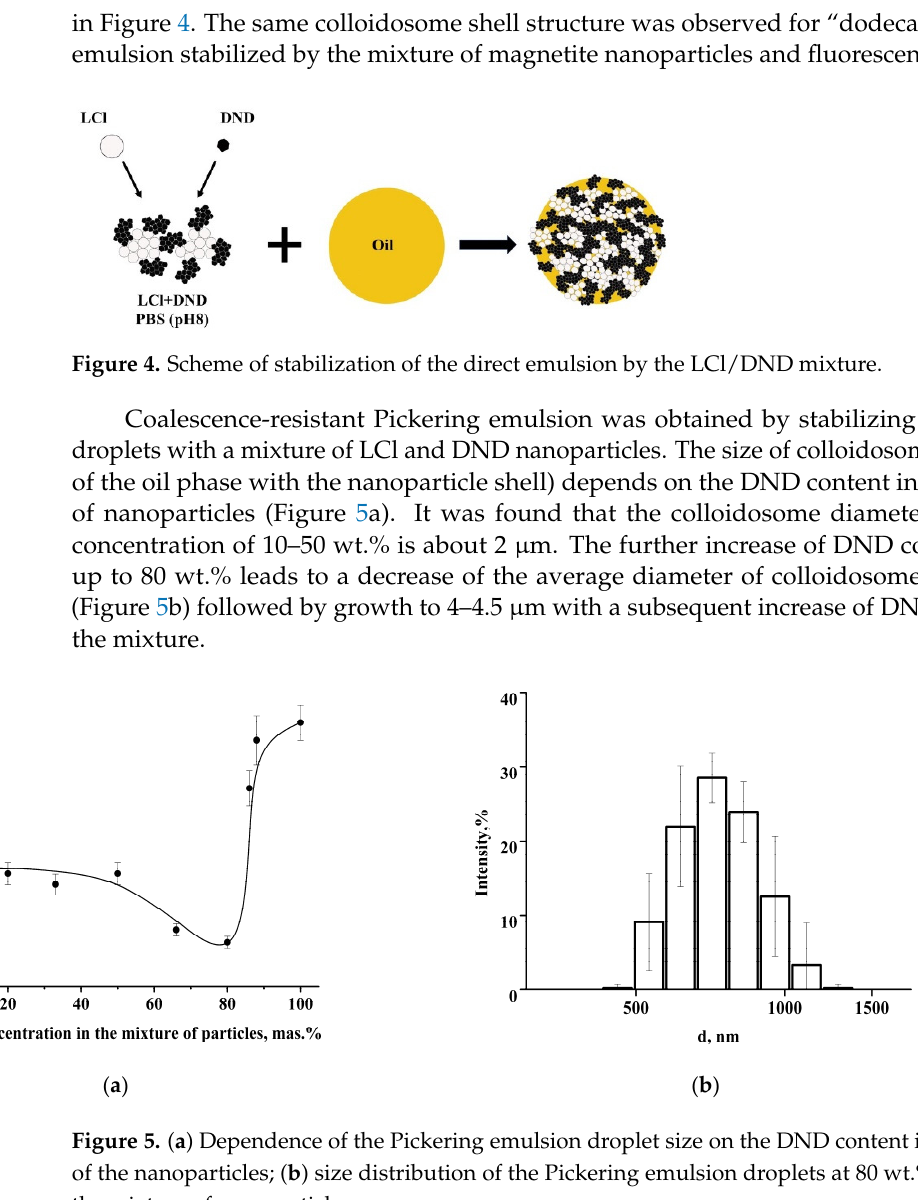
( b ) Figure 3. Energy of interaction: ( a ) between the nanoparticles; ( b ) between the clusters of the LCl and DND nanoparticles. Clusters of 350 nm of DNDs, 660 nm of LCl, and their 1.8 μ m aggregates were taken into account to calculate the DND/LCl interaction. Parameters K s and A 12 for the interac- tion of clusters were the same for the interaction of individual particles (Table 1). Figure